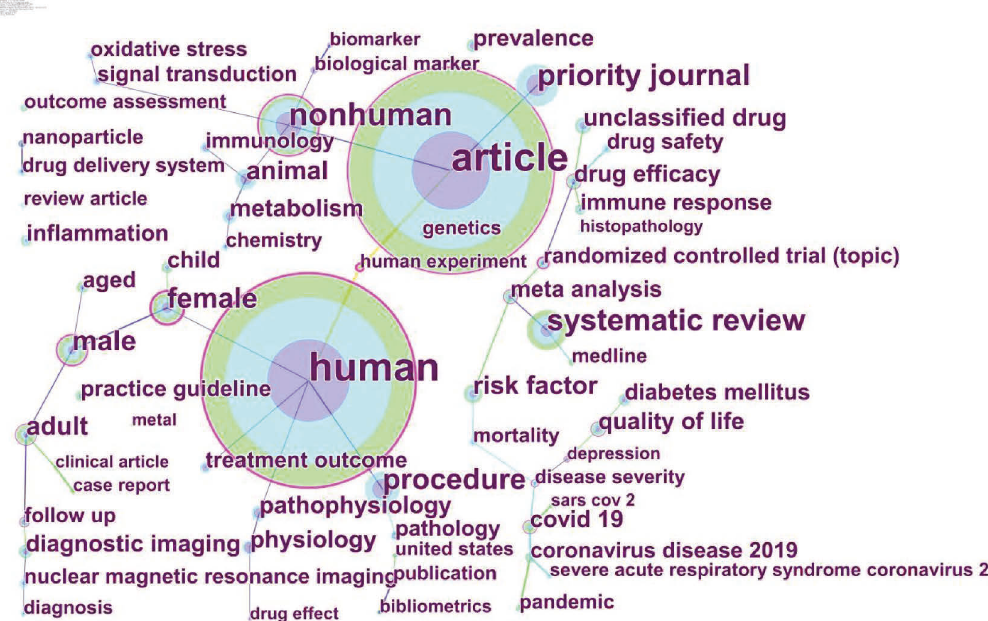
Figure 36: Co-occurring keyword network for review